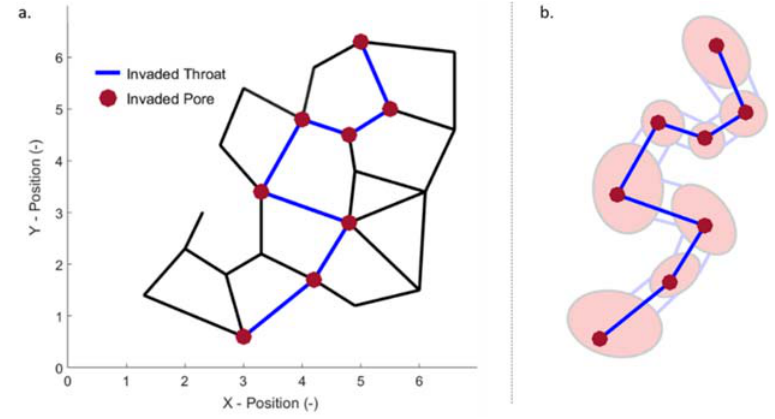
Figure 8. ( a ) PNM simulation result, ( b ) invasion pattern comparison of simulation and experiment result. Liquid-filled throats are shown in black, invaded pores in red, and invaded throats in blue. Liquid-filled pores are not shown.